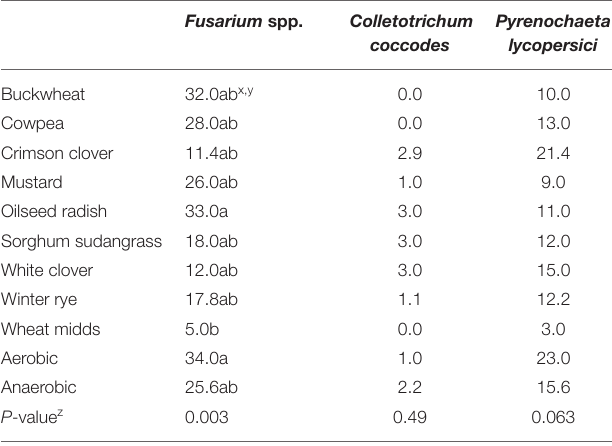
TABLE 2 | Average incidence of root piece infection by various fungi for plants grown in soils treated with anaerobic soil disinfestation with various cover crop carbon sources and a wheat midds standard (20.2 Mg/ha).